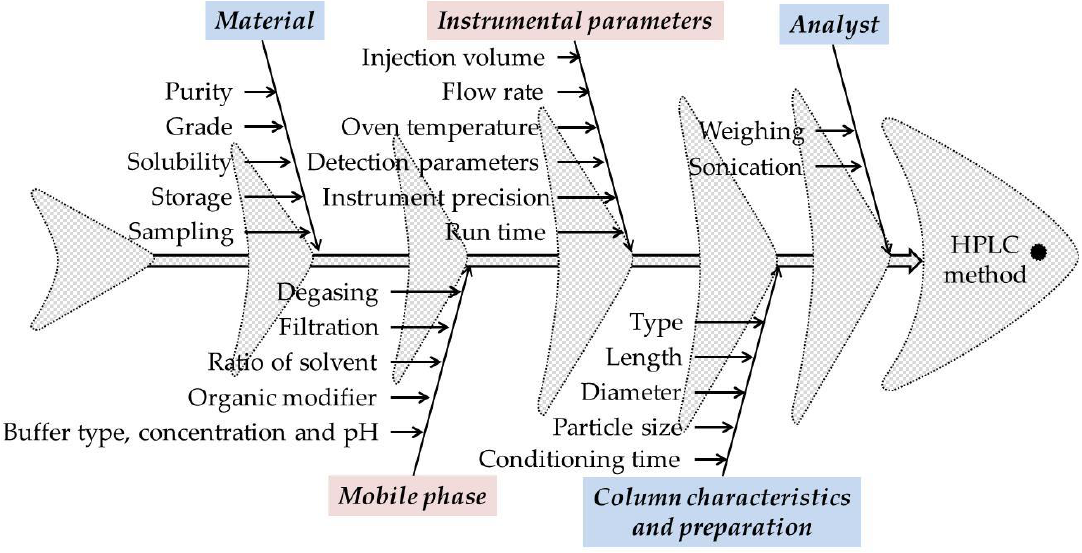
Figure 2. The Ishikawa (fishbone) diagram to identify potential variables in HPLC method devel- opment.